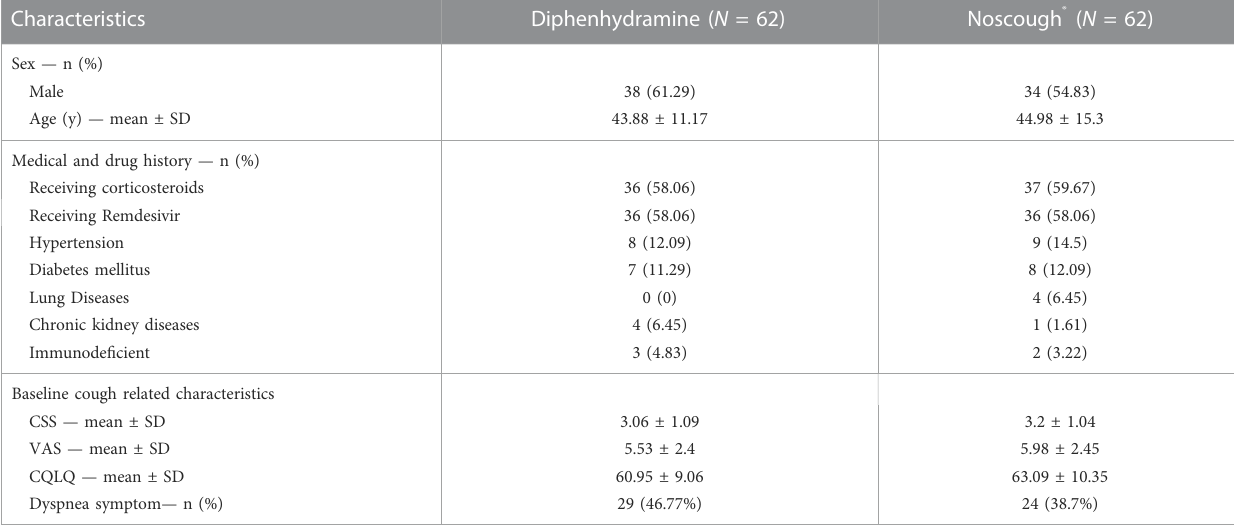
TABLE 1 Demographics and past medical histories of the patients. Characteristics